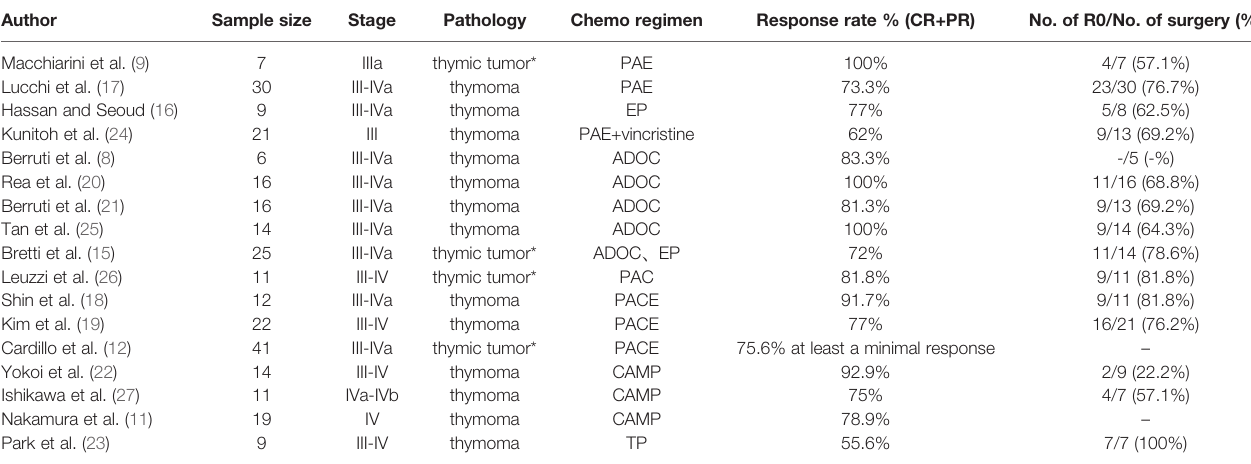
TABLE 1 | Induction chemotherapy for locally advanced